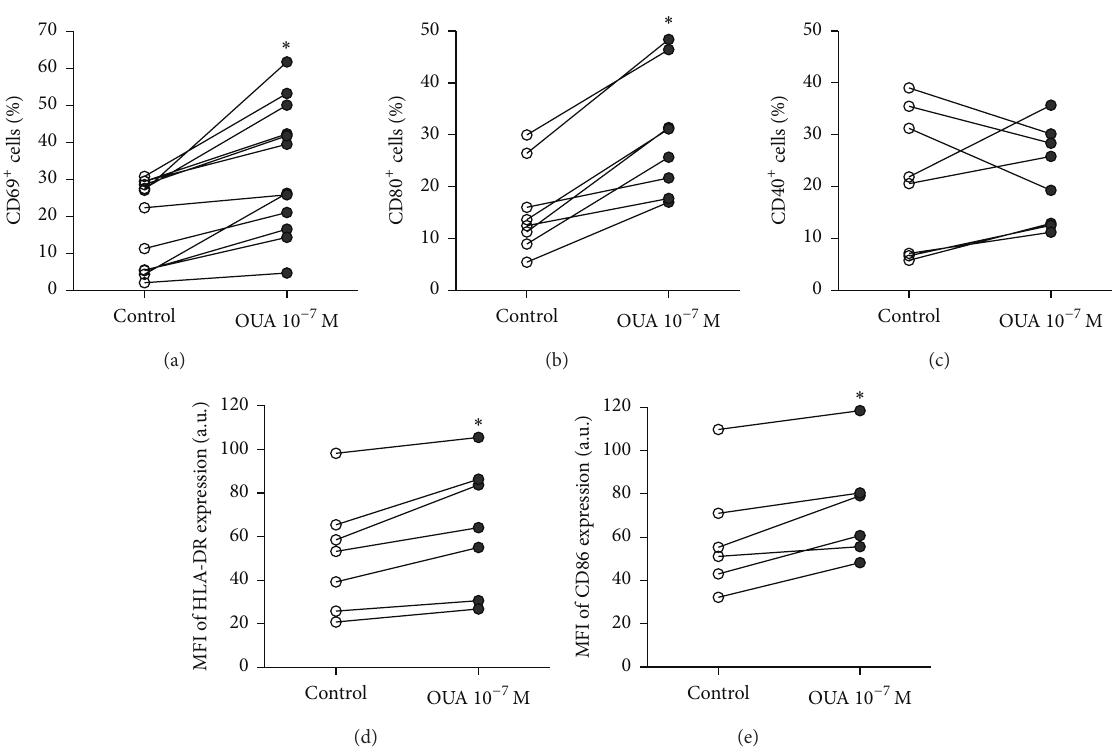
Figure 1: Ouabain affects the expression of CD69, HLA-DR, and costimulatory molecules on monocytes. Cells were cultured for 24 hours in the absence or presence of ouabain 10 −7 M; thereafter, cells were incubated for 30 minutes with specific antibodies, as described in Methods. Scatter plots are shown for the percentage of CD69 + (a), CD80 + (b), and CD40 + (c) cells and the mean fluorescence intensities of HLA-DR (d) and CD86 (e) after 24 hours of incubation in the presence and absence of 10 −7 M of ouabain. Each line represents the data from one specific donor. ∗ 𝑃 < 0.05 using two-tailed paired t